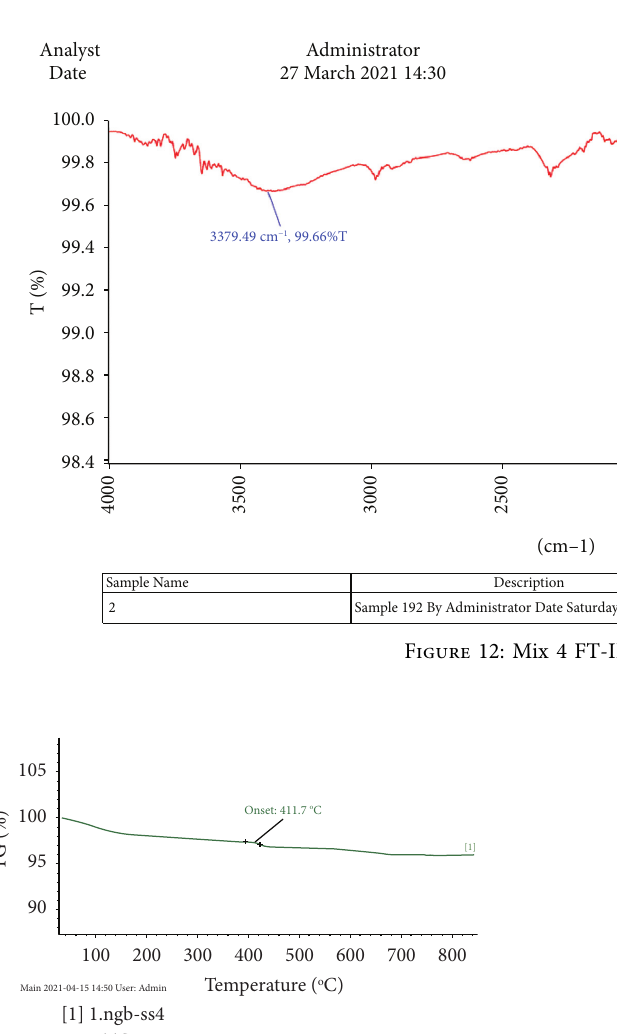
Figure 15: Scanning electron microscopy (SEM) of mix